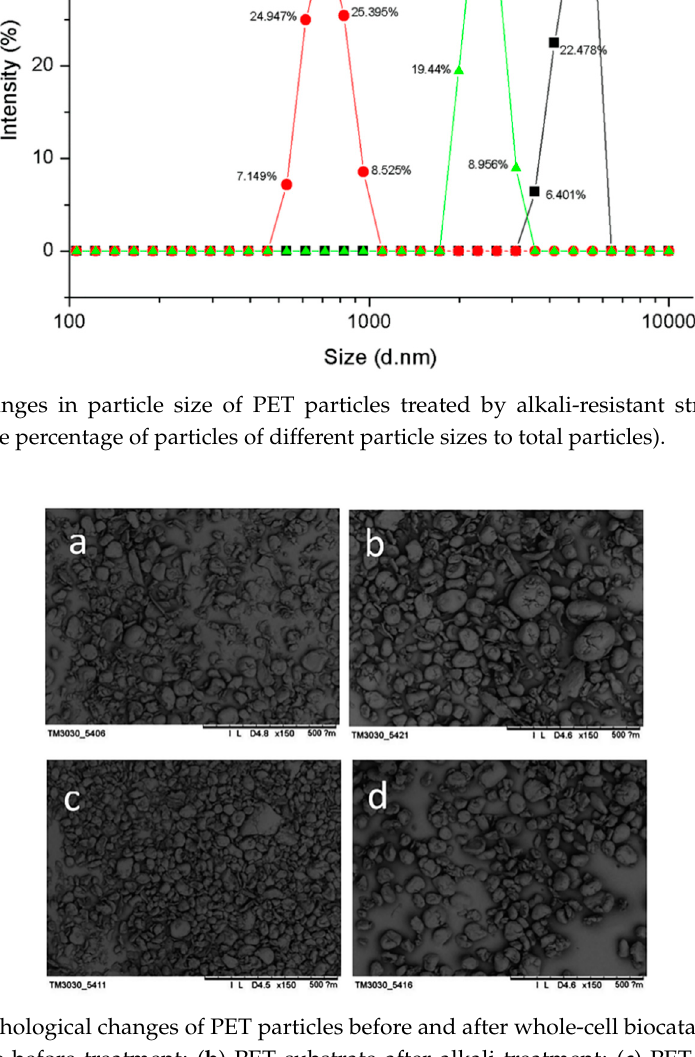
Figure 5. Changes in particle size of PET particles treated by alkali-resistant strain and alkali (Intensity %: the percentage of particles of different particle sizes to total particles).